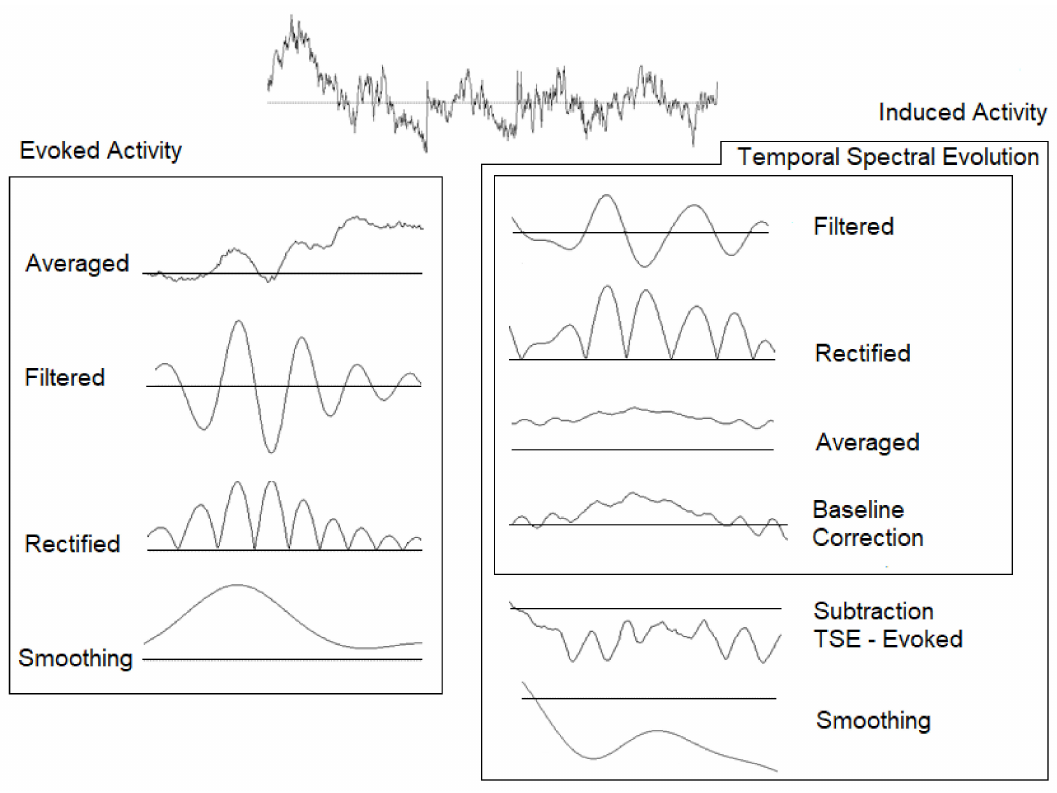
Figure 2. Temporal spectral evolution